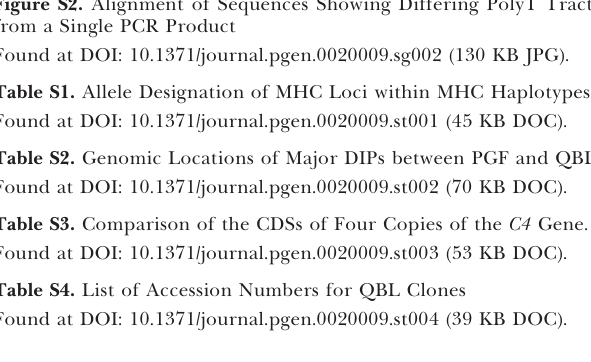
Figure S1. Frequency Distribution of DIP Sizes between Haplotypes Found at DOI: 10.1371/journal.pgen.0020009.sg001 (48 KB PPT). Figure S2. Alignment of Sequences Showing Differing PolyT Tracts from a Single PCR Product Found at DOI: 10.1371/journal.pgen.0020009.sg002 (130 KB JPG). Table S1. Allele Designation of MHC Loci within MHC Haplotypes Table S2. Genomic Locations of Major DIPs between PGF and QBL Table S3. Comparison of the CDSs of Four Copies of the C4 Gene. Table S4. List of Accession Numbers for QBL